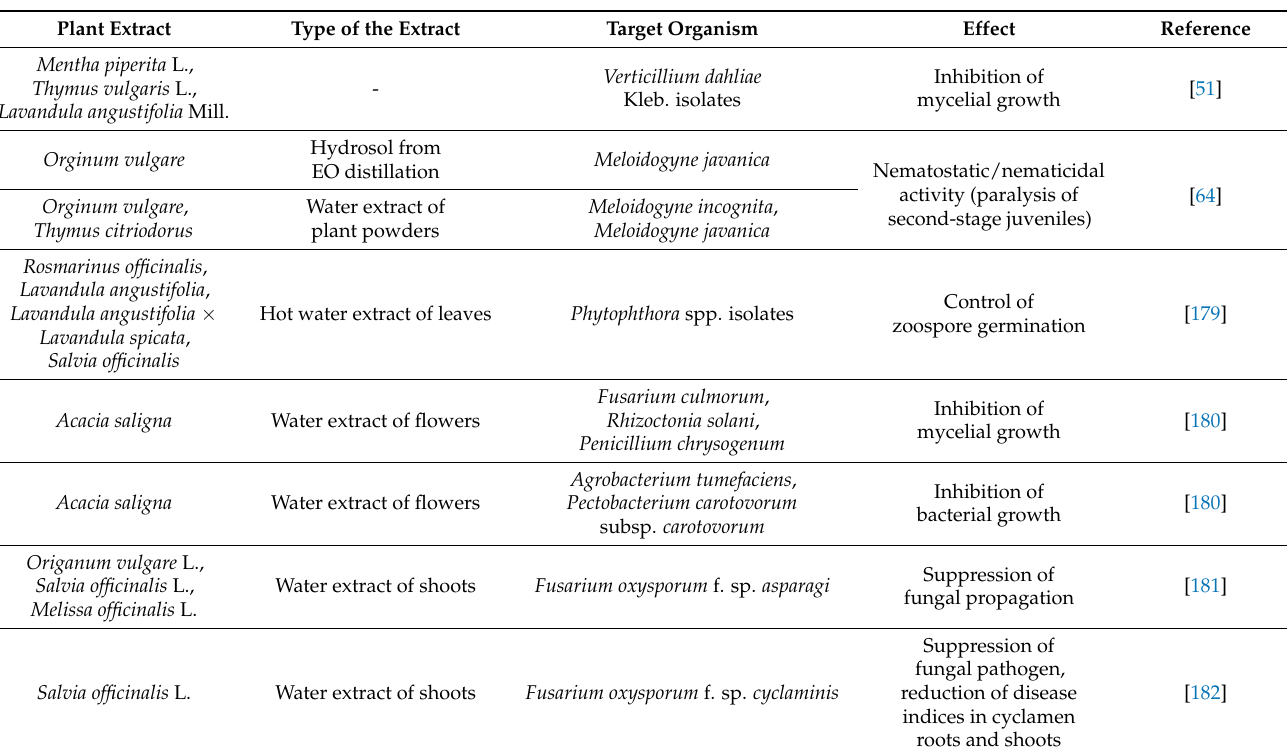
Table 2. Properties of extracts from aromatic and medicinal plants, dealt with in this review paper, against soil-borne organisms and related